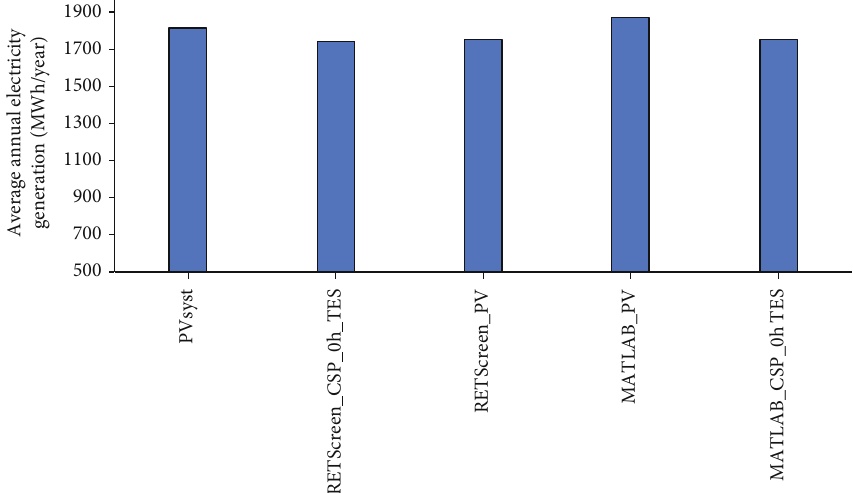
Figure 15: Comparison between di ff erent software.